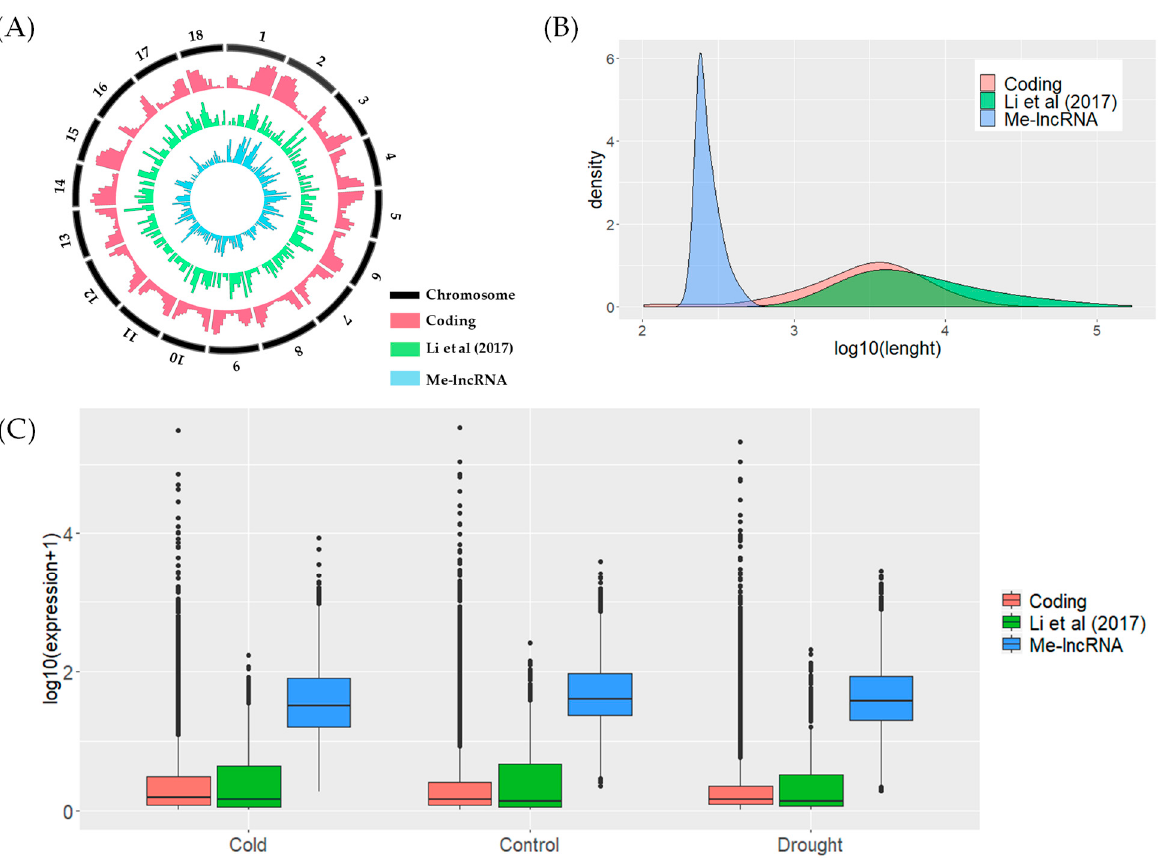
Figure 3. Comparison of protein-coding genes, lncRNA loci from Li et al. [15] and predicted novel lncRNA loci (Me-lncRNAs). ( A ) Distribution of coding genes, lncRNA loci from Li et al. [15] and Me-lncRNAs along 18 chromosomes of cassava. ( B ) Size distribution of coding genes, lncRNA loci from Li et al. [15] and Me-lncRNAs. ( C ) Boxplots of protein-coding genes, lncRNA loci from Li et al. [15] and Me-lncRNAs expression in control, cold and drought conditions.